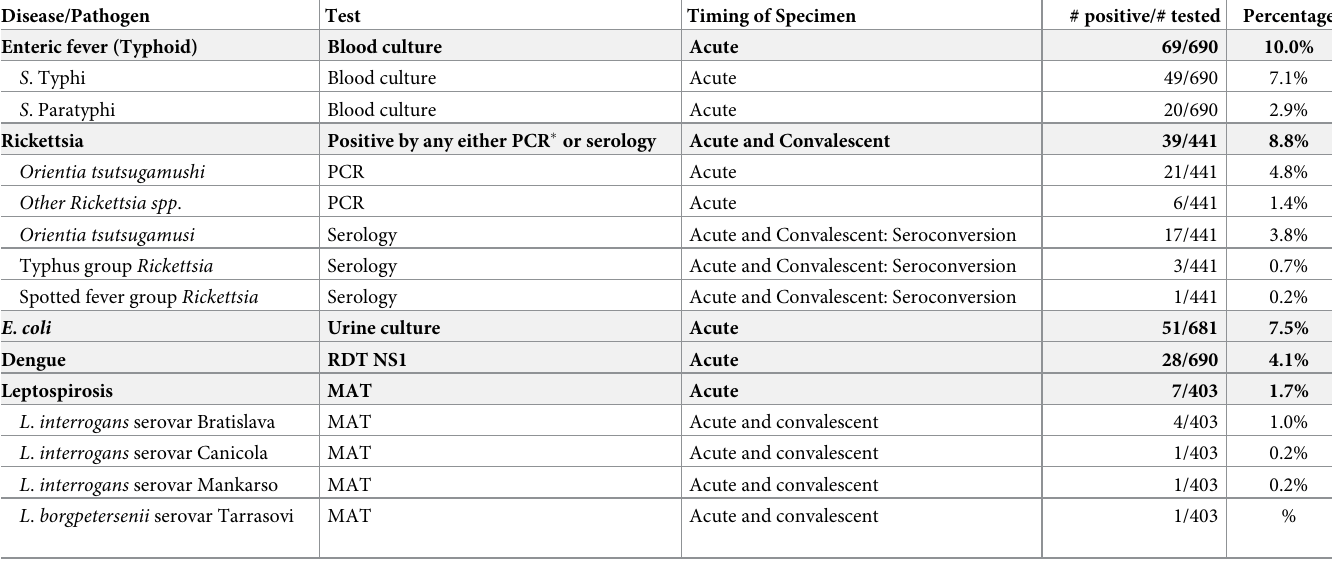
Table 2. Distribution of pathogens identified among acute febrile illness (AFI) patients in Bangladesh, May 2019-March 2020.